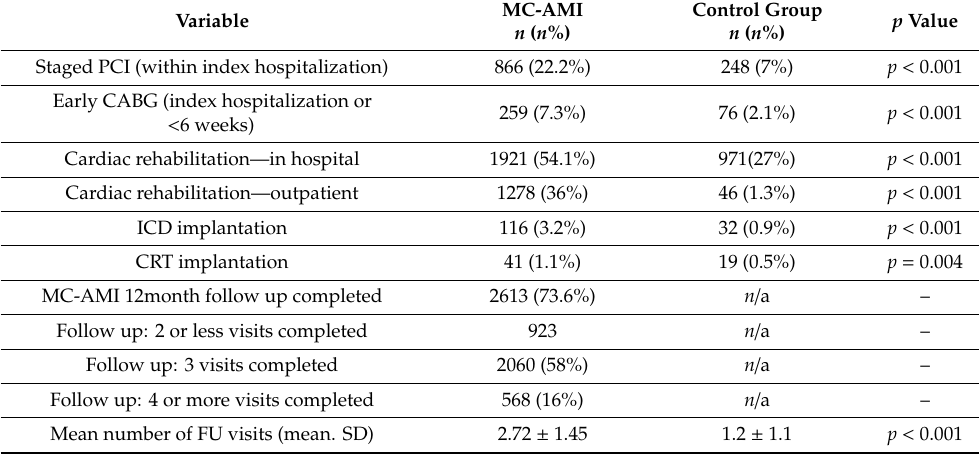
Table 4. Implementation of the key components of the program in the managed care in acute myocardial infarction (MC-AMI) group and respective interventions in control (if